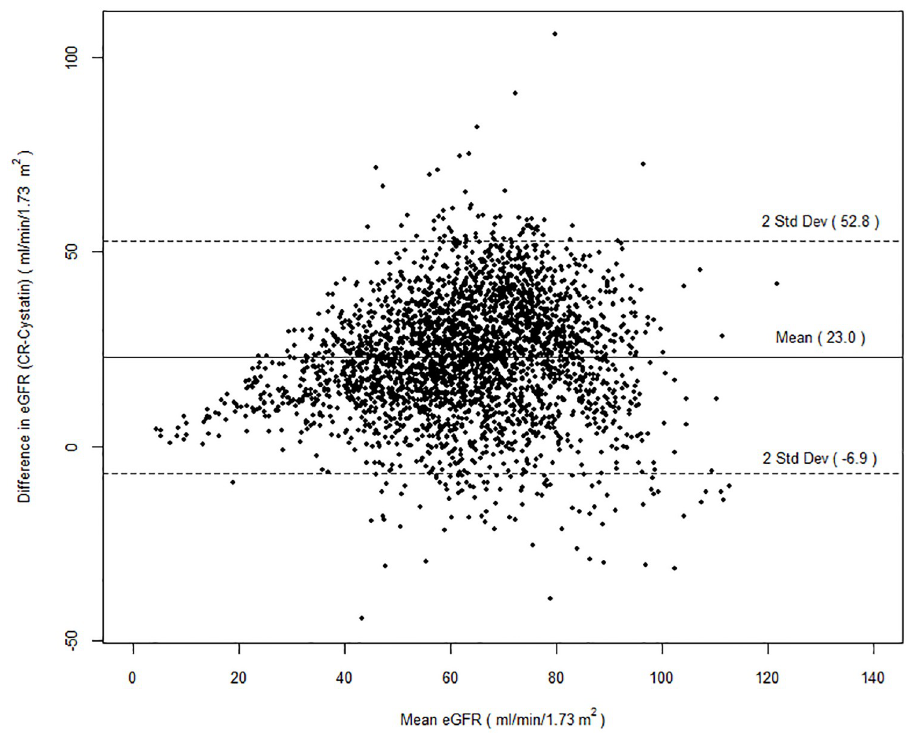
Fig 1. Bland-Altman plot of the difference in creatinine-based estimated glomerular filtration rate (eGFR cr ) and cystatin C-based estimated glomerular filtration rate (eGFR cys ) versus the mean of the two estimates.